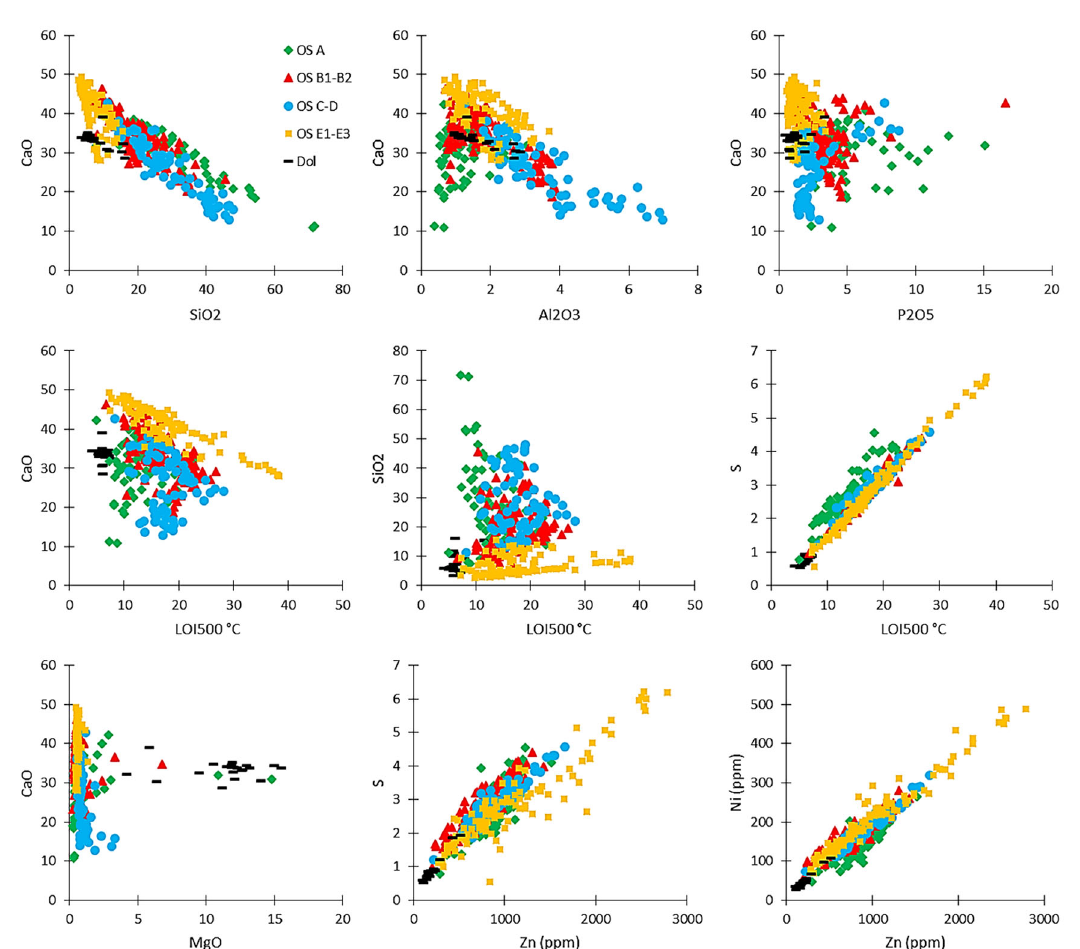
Fig. 2. A selection of X–Y plots between 9 elements, selected out of the studied 18 using analytical data on single samples. The plots demonstrate the best examples of variable nature of correlations between certain different components of the oil shale (OS) unit in total: (i) strong negative (CaO vs SiO 2 ) or moderate negative (CaO vs Al 2 O 3 ) or scattered (CaO vs P 2 O 5 ) correlation between the main mineral components of OS, (ii) scattered (diffuse) correlation between the CaO and SiO 2 contents and LOI500°C, the latter reflecting the content of organic matter, (iii) strong positive correlation between LOI500°C and S, and further on between S and Zn, and Zn and Ni. The plots reflect also distinct geochemical differences between certain layers and the rest of samples, e.g. layers C and D on the CaO vs Al 2 O 3 plot and layers E1–E3 on many plots. The MgO vs CaO plot expresses the presence of elevated MgO contents only in barren dolomitic limestone layers.